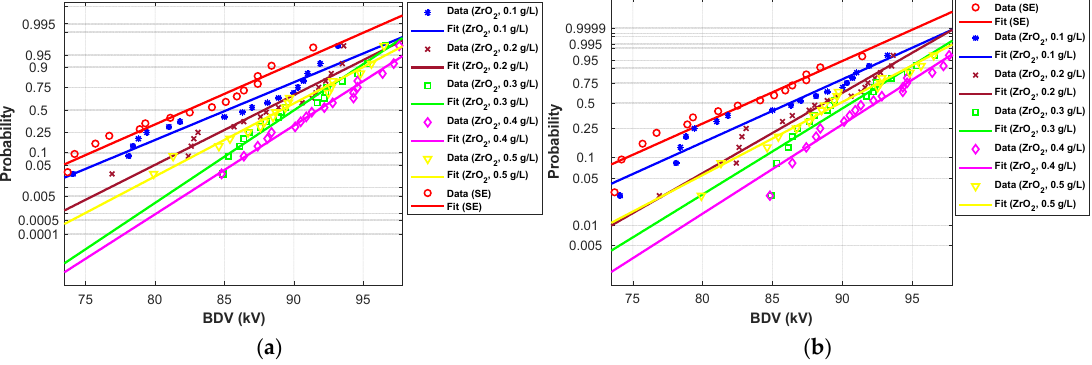
Figure 18. Probability plot of breakdown voltage data of SE-based nanofluids with ZrO 2 (20–30 nm) for 2.5 mm electrode gaps; ( a ) normal and ( b ) extreme value. Table 7. The AC BDV at 1, 10, and 50% probability levels evaluated from normal and extreme value fit